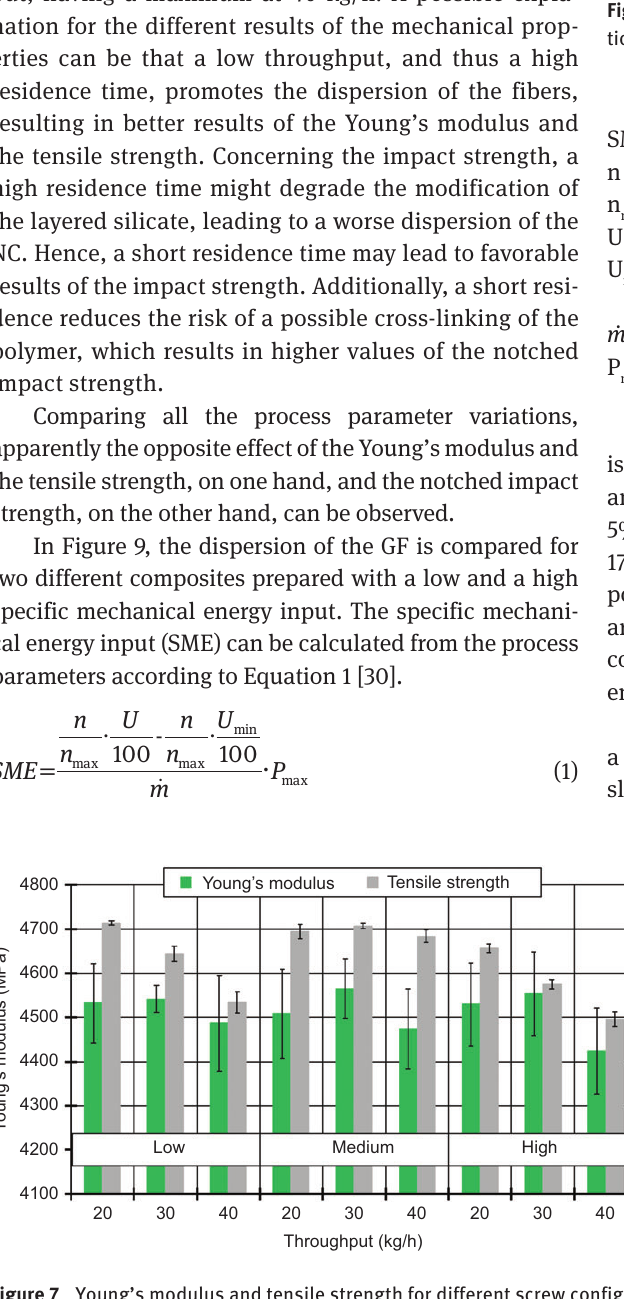
Figure 7 Young ’ s modulus and tensile strength for different screw configurations at 20, 30, and 40